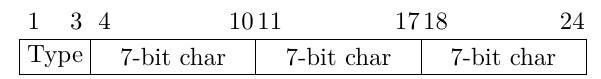
Figure 5: Structure of 2G ALE TO, TIS and TWAS words. The type bits are 010 for TO, 101 for TIS and 011 for TWAS